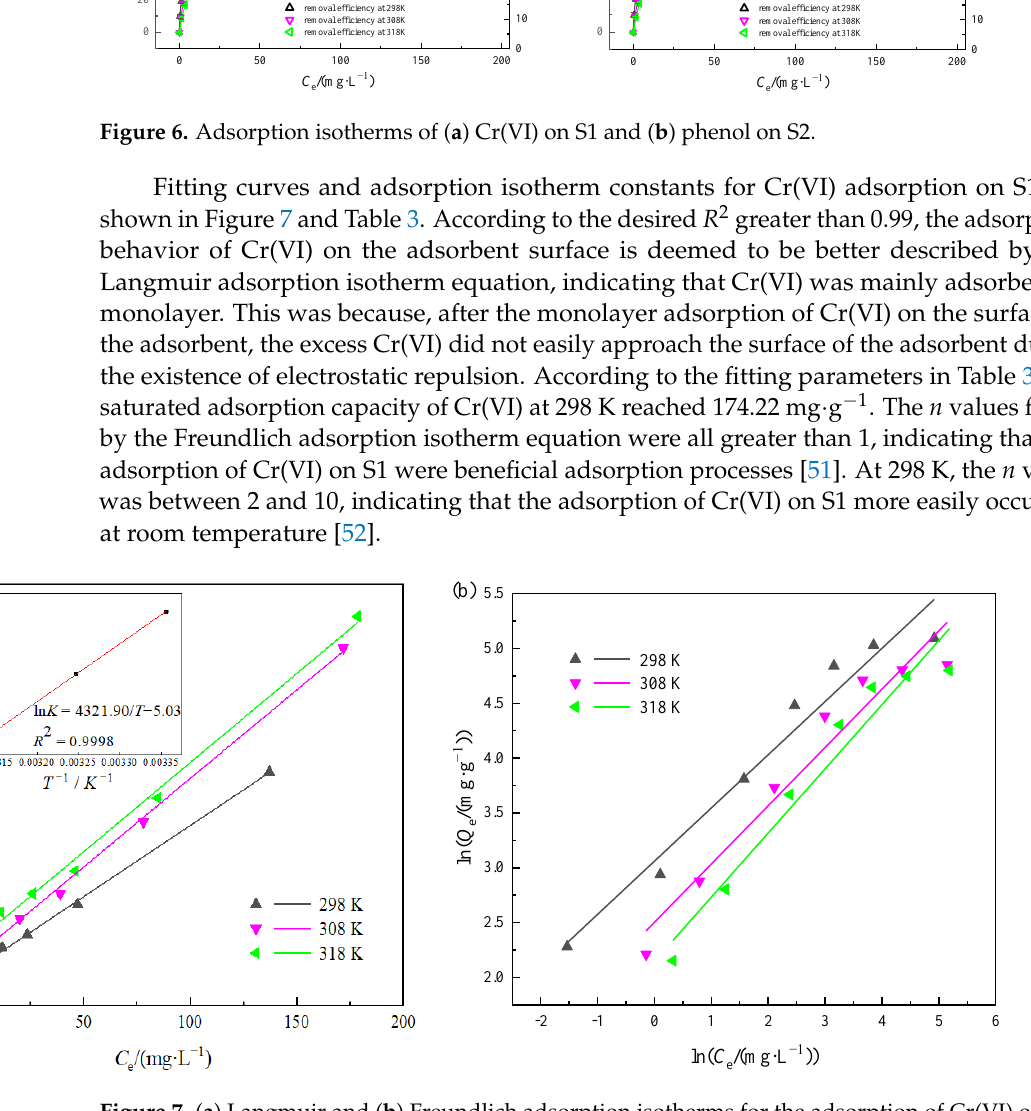
Figure 7. ( a ) Langmuir and ( b ) Freundlich adsorption isotherms for the adsorption of Cr( Ⅵ ) on S1. According to the Langmuir adsorption isotherm constant K L , the thermodynamic equilibrium constant K was obtained by getting rid of the unit. The plot of ln K vs. 1/ T for thermodynamic parameter calculation is shown in the inset picture of Figure 7(a). The thermodynamic parameters calculated for Cr( Ⅵ ) adsorption on S1 are shown in Table 3. Δ H ＜ 0 indicated that the adsorption was an exothermic process. Reducing the tempera- ture was conducive to adsorption, and the adsorption was enthalpy-driven adsorption- type behavior. Δ S ＜ 0 indicated that the adsorption of Cr(VI) on S1 reduced the disorder degree of the system, and the adsorption was not entropy-driven adsorption-type behav- ior. Δ G ranged from − 23.41 kJ·mol − 1 to − 22.58 kJ·mol − 1 . The negative values of Δ G indicated that the adsorption was a spontaneous process. Moreover, it could be inferred that the adsorption driving force was more than the typical physical interactions since studies have shown that the Δ G of physical adsorption was − 20 – 0 kJ·mol − 1 and the Δ G of chemical adsorption was − 400 – − 80 kJ·mol −1 [53 ]. Δ G of between − 40 kJ·mol − 1 and − 20 kJ·mol − 1 sug- gested to us that the main adsorption force might have been the electrostatic coulombic attraction [54]; this was consistent with our previous work on the adsorption of Cr(VI) to PDMAEMA chains [28]. Table 3. Adsorption isotherm constants and thermodynamic parameters for Cr( Ⅵ ) adsorption on S1 and phenol adsorption on S2. Systems